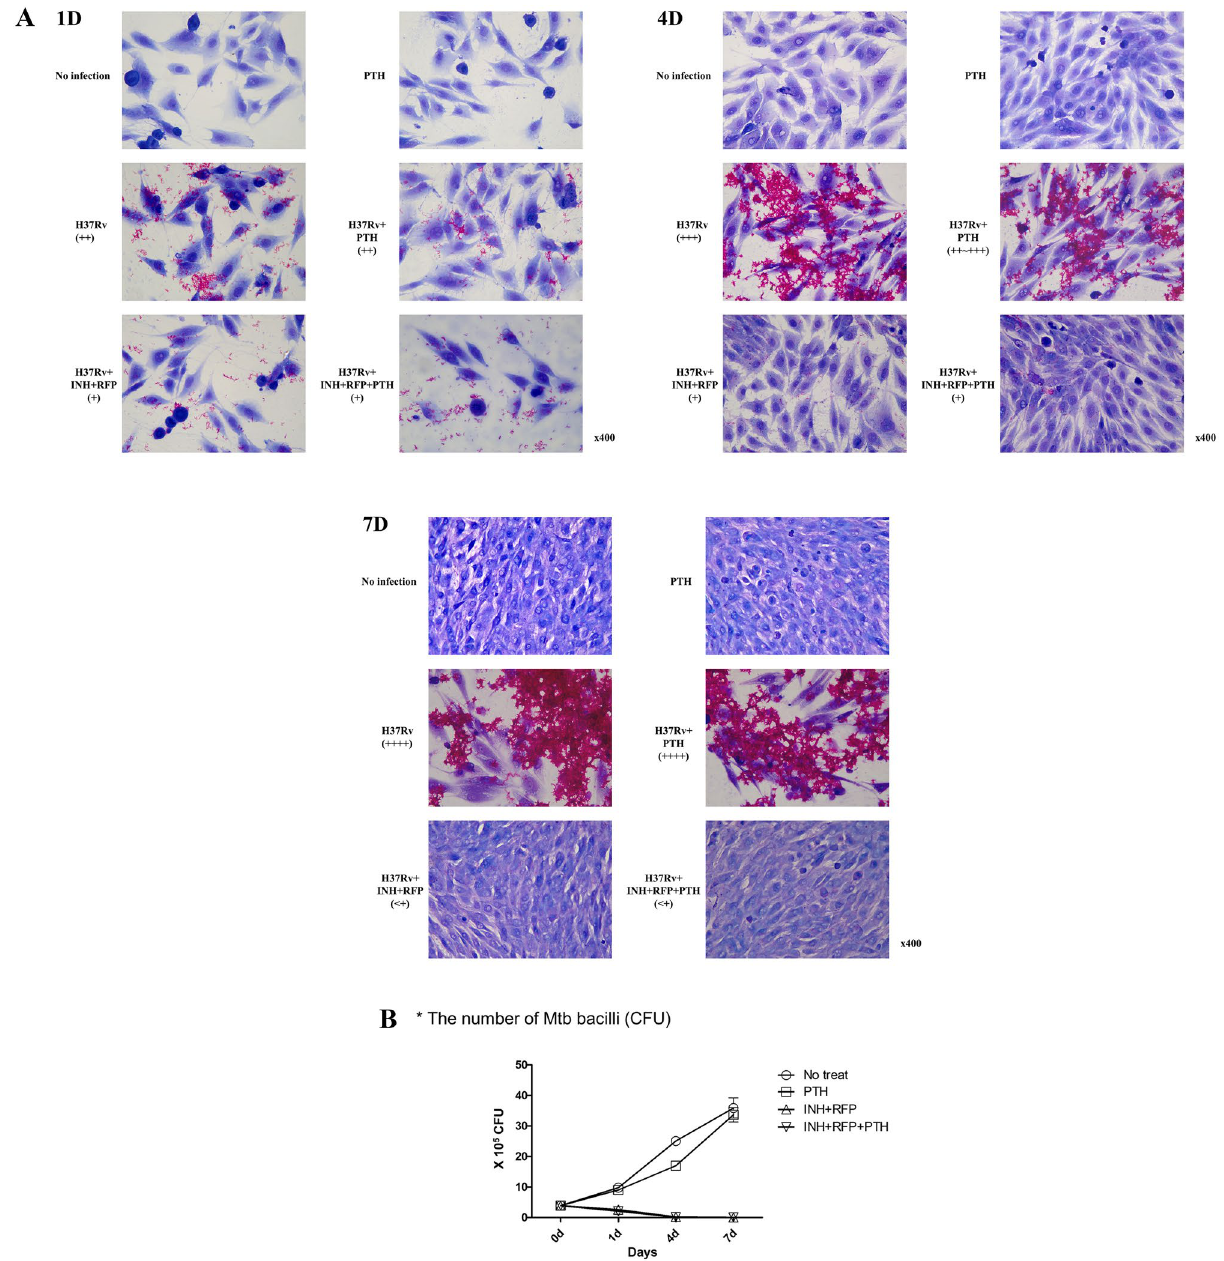
Figure 2. Microscopic images of acid fast bacillus (AFB) and Giemsa staining results. ( A ) + : < 500 bacili, + + : 500–1000 bacilli, + + + : 1000–3000 bacilli, + + + + : > 3000 bacilli). 400 × magnification. ( B ) CFU results. ( A ), 1 day after drug administration (1D). Anti-tuberculosis drugs showed slight inhibitory effect on Mtb growth, 4 days after drug administration (4D). Growth of Mtb increased, and anti-tuberculosis drugs significantly inhibited Mtb activity. No apparent difference was observed in osteoblast density according to concentration of teriparatide administered, 7 days after drug administration (7D). Significant proliferation of osteoblasts was evident. Mtb proliferation was significantly increased in the absence of anti-tuberculosis drugs. Anti- tuberculosis drugs completely inhibited bacterial growth. No apparent difference was observed in osteoblast density according to teriparatide administration; ( B ), CFU results by time point. Mtb activity of infected MG-63 increased four-fold for 7 days. Mtb was eradicated by anti-tuberculosis drug. Teriparatide did not affect Mtb activity. Abbreviations: AFB, acid-fast bacilli; CFU, colony-forming units; INH, isoniazid; PTH, teriparatide; RFP, rifampin; Mtb, Mycobacterium tuberculosis